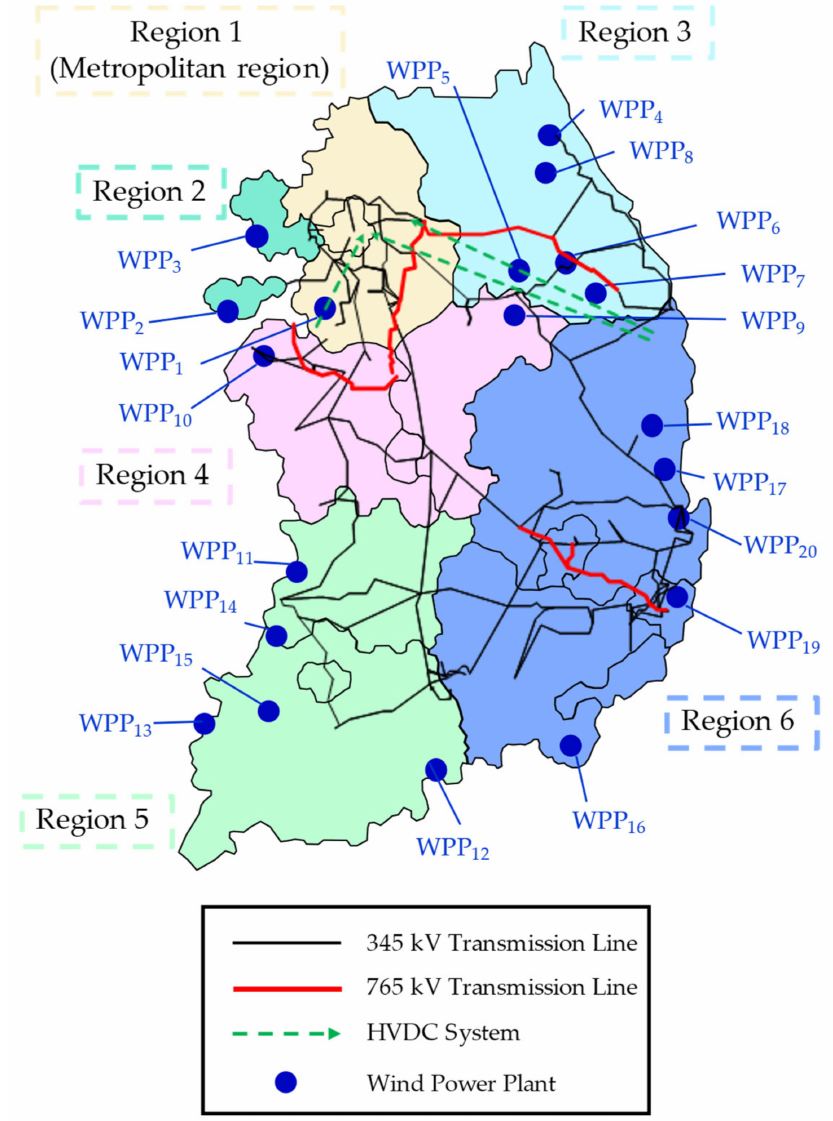
Figure 6. Korean electric power system with high penetration of